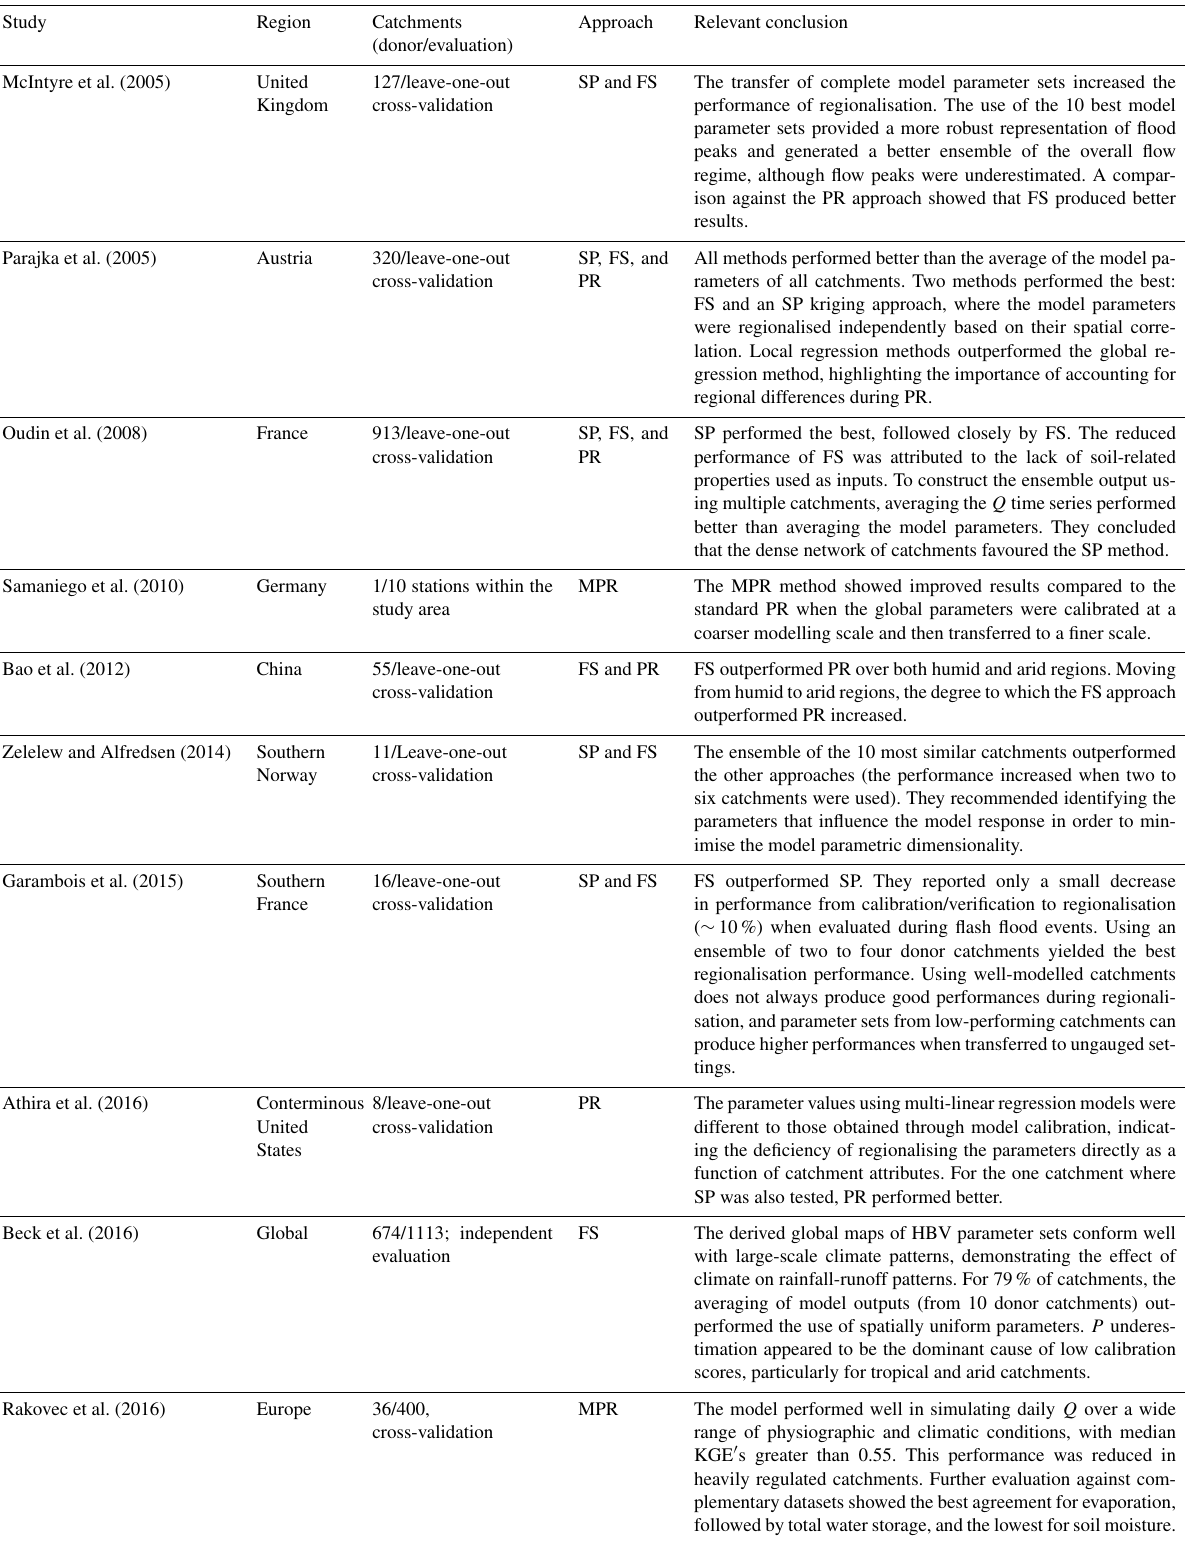
Table 1. Summary of selected regionalisation studies that used spatial proximity (SP), feature similarity (FS), parameter regression (PR), or multiscale parameter regionalisation (MPR). This study has been added for